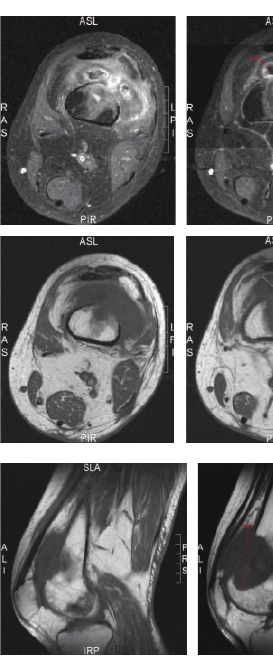
or complications that required follow-up surgery. The